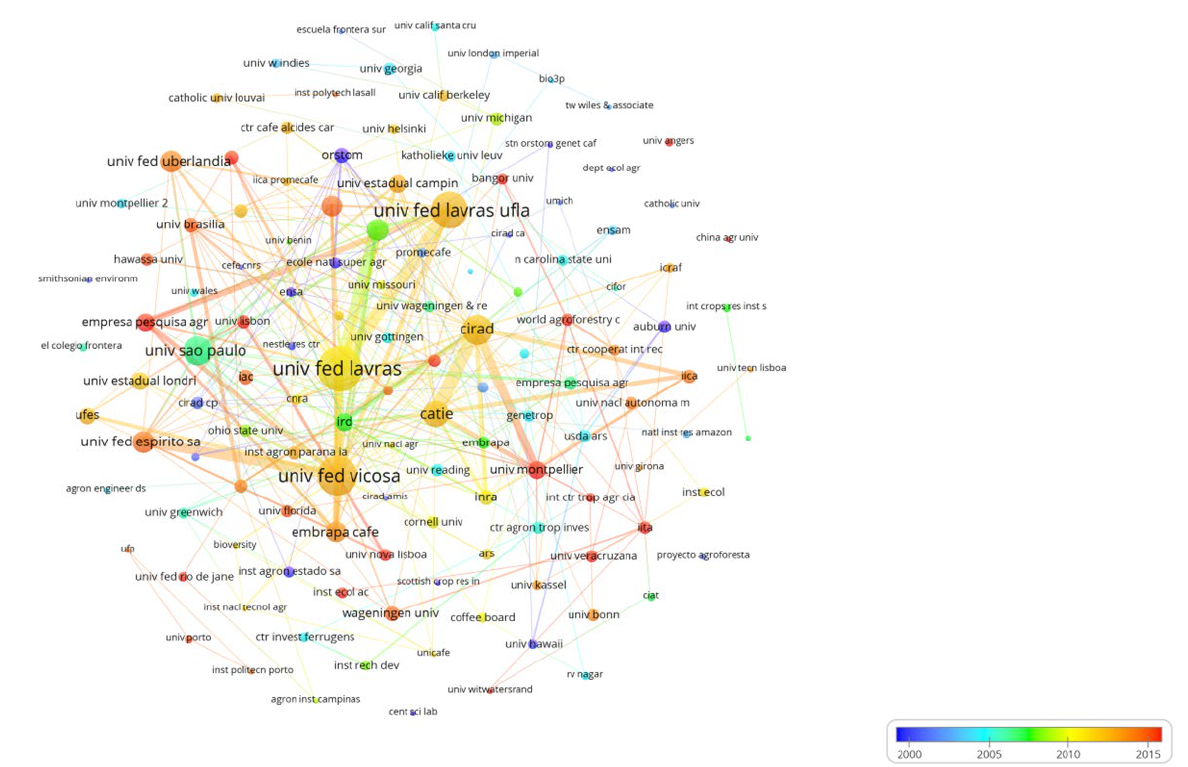
Figure 5. Coffee agronomy research coauthorship network, organizations level.